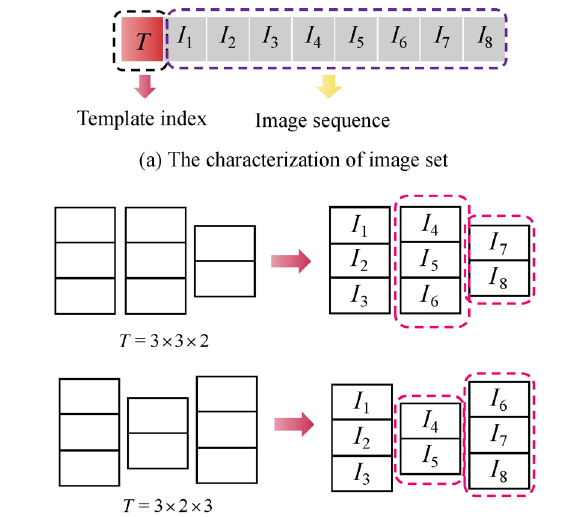
Fig. 3 Illustration of image set characterization and the mapping rule of templates. The collages in pink dash boxes are different.